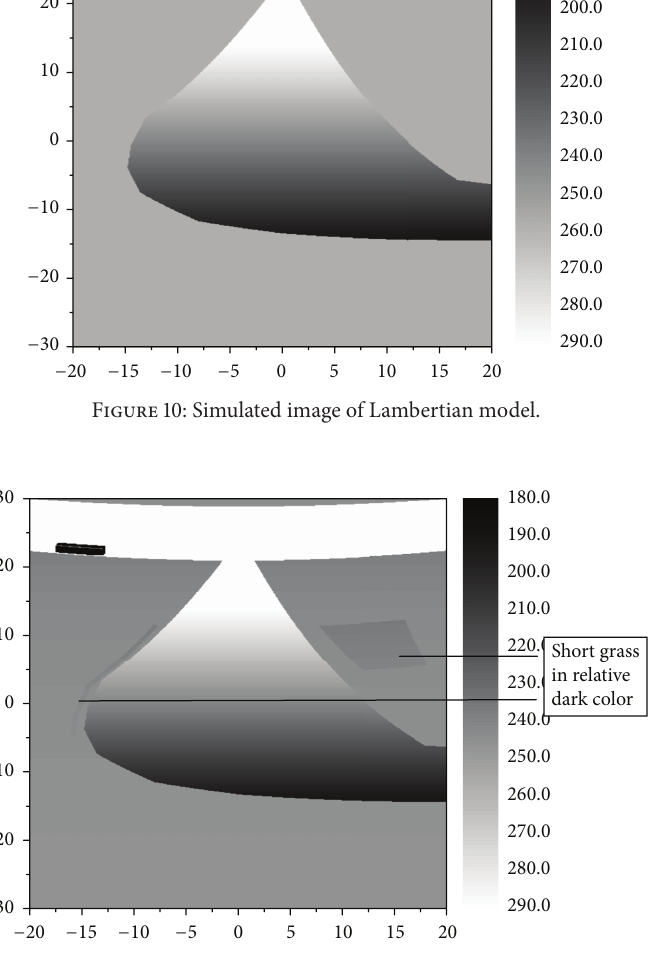
Figure 11: Simulated image of improved model.